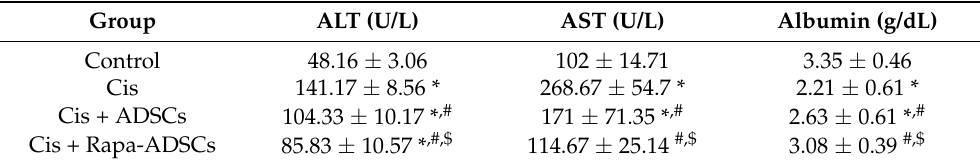
Table 2. The impact of rapamycin-preconditioned ADSCs on liver biochemical parameters; ALT, AST and albumin, after cisplatin (Cis)-induced liver damage.